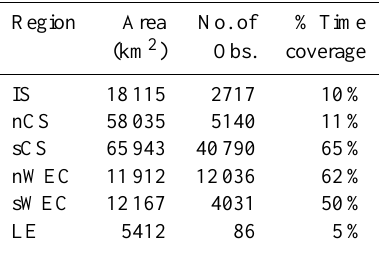
Figure 4. Map of available SOCAT and LDEO surface p CO 2 data with color-coded respective year of acquisition between 2003 and 2011. Table 1. Area (in km 2 ) of each defined province (Fig. 2), number of available SOCAT/LDEO p CO 2 data and the percentage of available monthly SOCAT/LDEO p CO 2 data between 2003 and